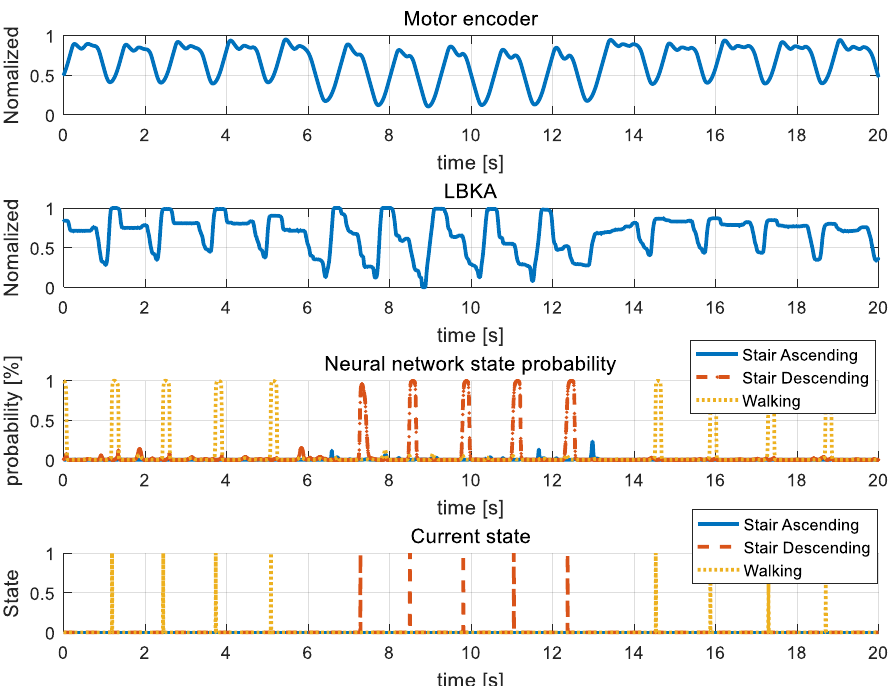
Figure 15. Mixed stair ascending experiment. In the graph, sensor data and neural network result in walking → stair ascending → walking mixed state are plotted. Also, the current state determined by state decision algorithm is plotted.